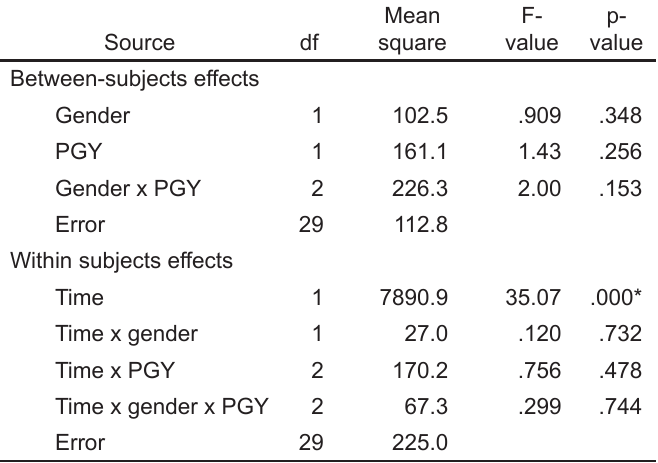
Table. Results of a three factor (2x2x3) analysis of variance with one repeated measure involving 35 emergency medicine